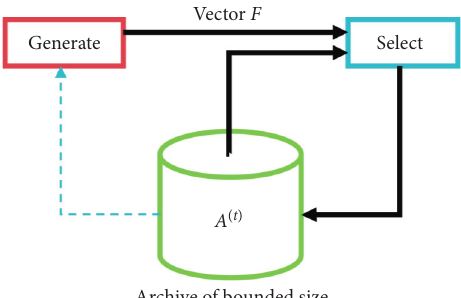
Figure 2: Block structure of archive-based selection